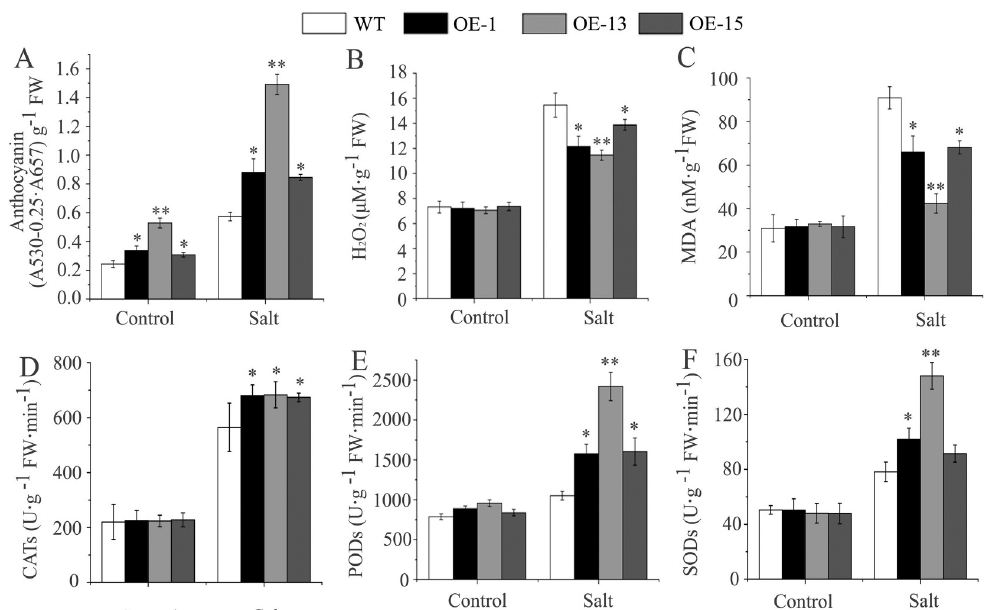
Fig 8. The changes in physiological indices in AmDREB3 transgenic Arabidopsis under salt stress. Three-week-old seedlings were watered with a 300 mM NaCl solution, and the contents of anthocyanins, H 2 O 2 , and MDA as well as the activities of CAT, POD, and SOD were measured before (control) and 5 d after watering with the NaCl solution. Data are presented as means ± SDs (n = 3). Asterisks and double asterisks indicate significant differences of transgenic lines (OE-1, OE-13, and OE-15) compared to wild-type (WT) at p < 0.05 and < 0.01, respectively.